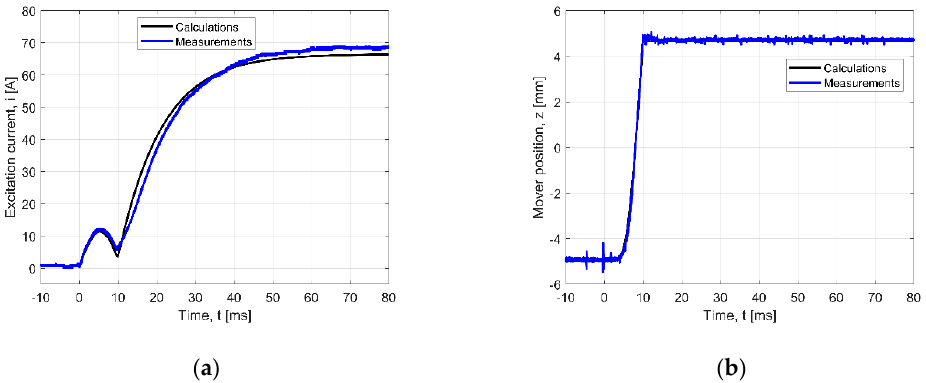
Figure 11. Verified transients for loaded state (springs added) and for increased voltage ( U = 25 V): ( a ) current wave, ( b ) position